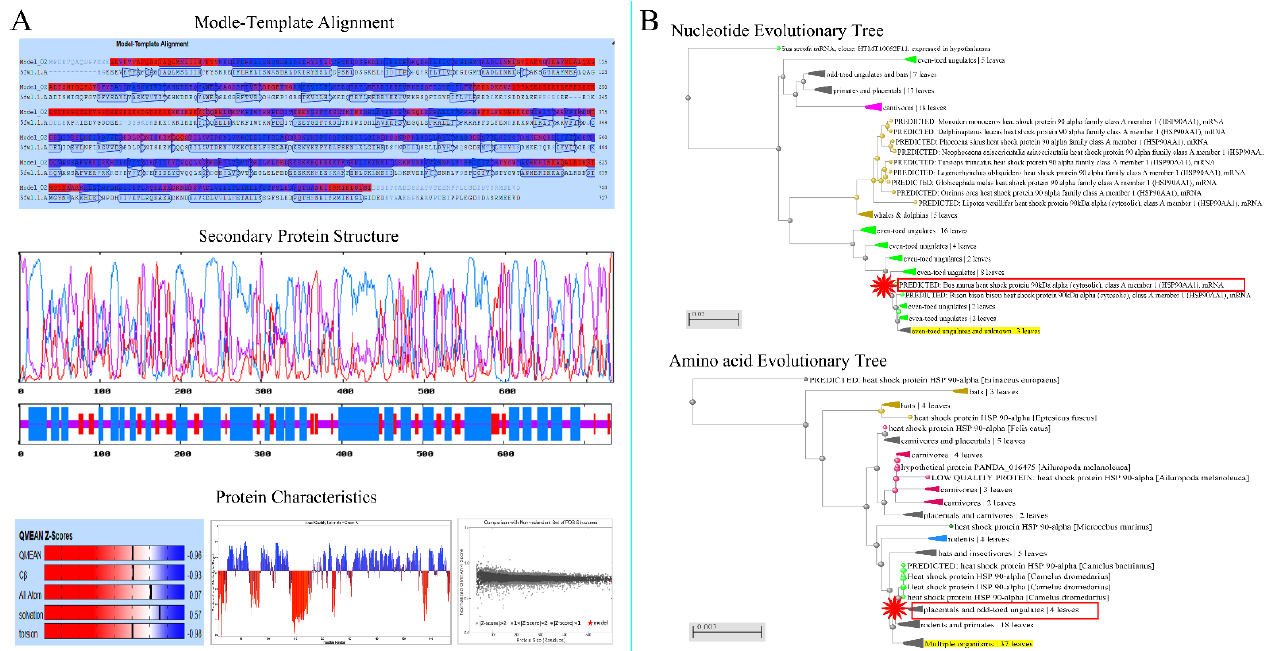
Figure 1. Physicochemical and evolutionary tree analysis of Hsp90 in cattle – yak. ( A ) The physical and chemical properties of Hsp90 in cattle – yak. Modle-template alignment, secondary protein structure and protein characteristics. ( B ) Homology analysis of amino acids and nucleotides.